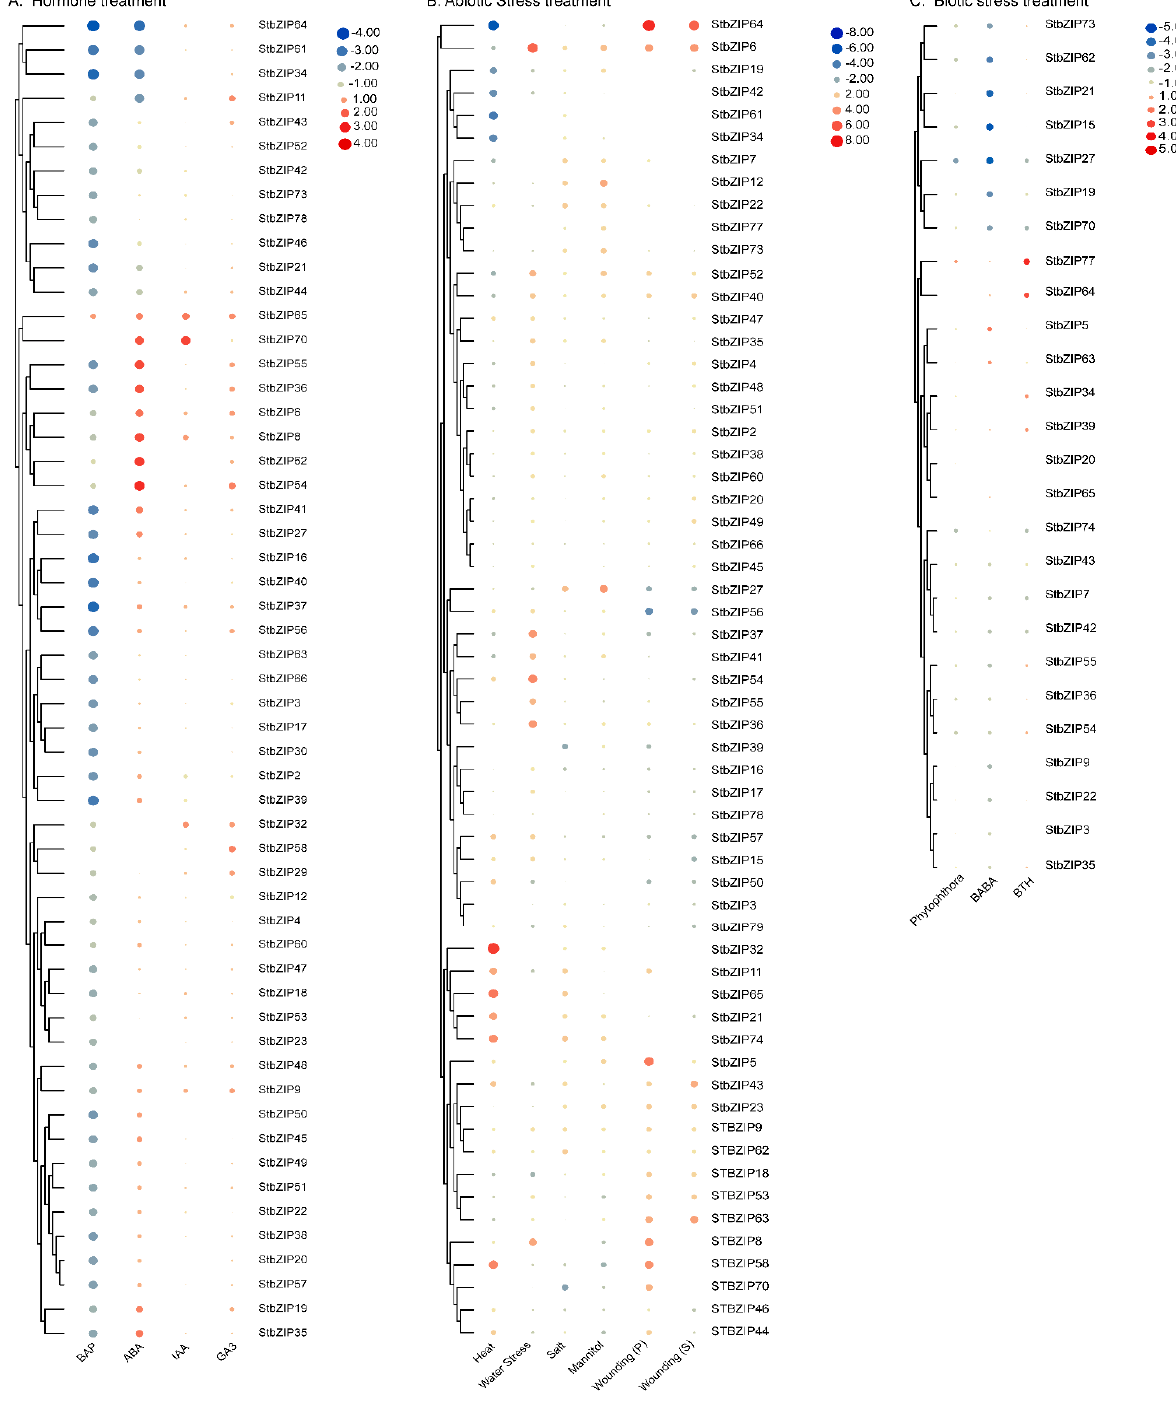
Figure 8. Heat map and hierarchical clustering of StbZIP transcript levels in response to the hormone, abiotic stress, and biotic stress. The independent gene expression datasets are detailed in Supplementary Table S3. The relative changes in bZIP gene expression levels were obtained following treatment with: ( A ) benzyl amino purine (BAP), abscisic acid (ABA), indole-3-acetic acid (IAA), or gibberellic acid (GA3); ( B ) heat, water stress, salt, mannitol, and wounding; ( C ) P. infestans , D,L- β -aminobutyric acid (BABA) or Benzo[1–3]thiadiazole-7-carbothionic acid (BTH ) . The log2 fold change values map to a color gradient from low (blue) to high (red) expression.